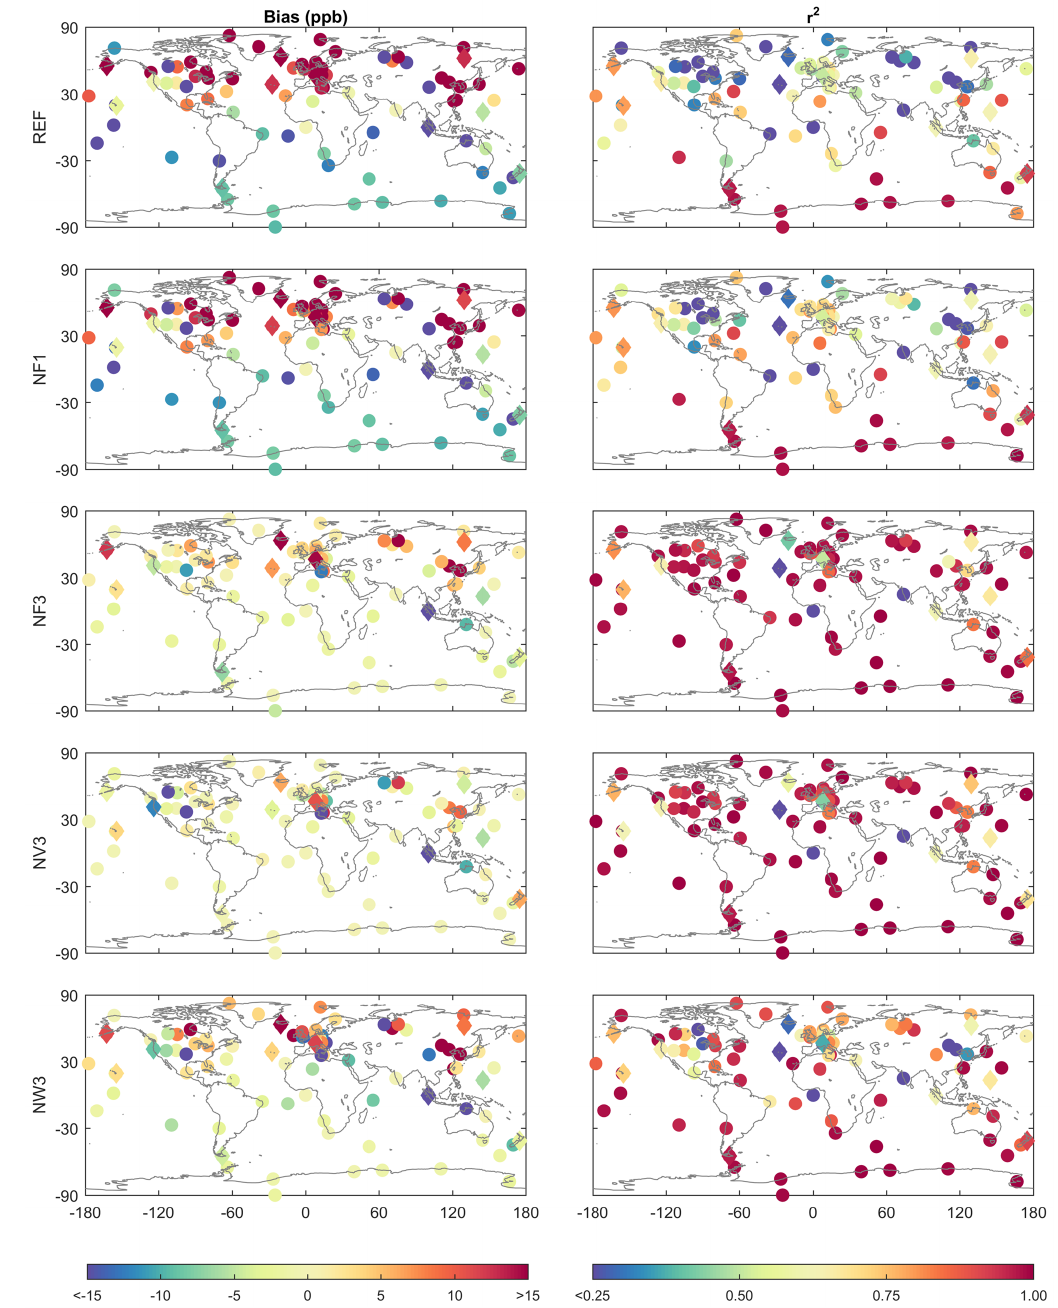
Figure 5. Bias and coefficient of determination of modelled methane at all surface stations, including validation stations (diamonds) for a selection of simulations (see Table 1 for settings). Some bias values exceed − 15ppb (also, see Fig. 4); colour limits were chosen to show the influence of nudging at the majority of